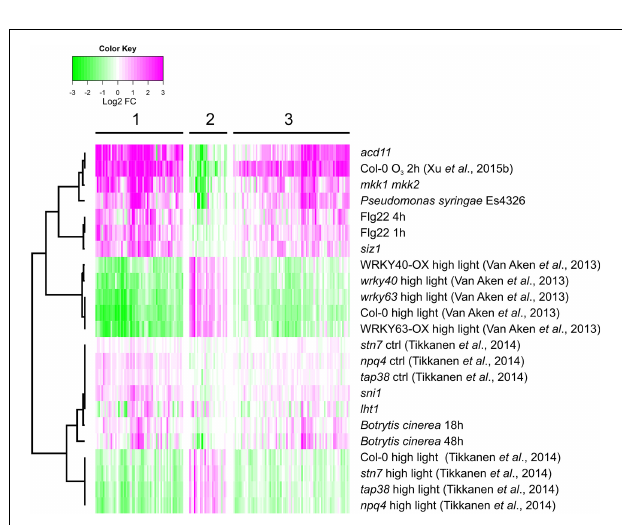
FIGURE 6 | Genes with contrasting expression between HL and O 3 – increased expression by O 3 , decreased expression by HL or vice versa, were identified from several O 3 RNA-seq and array HL experiments. 160 genes were found ( Supplementary Table 3 ), and subjected to bootstrapped Bayesian hierarchical clustering in log2-transformed fold changes from O 3 RNA-seq data and HL array experiments. Magenta and green indicate increased and decreased expression compared with untreated or wild type plants, respectively.